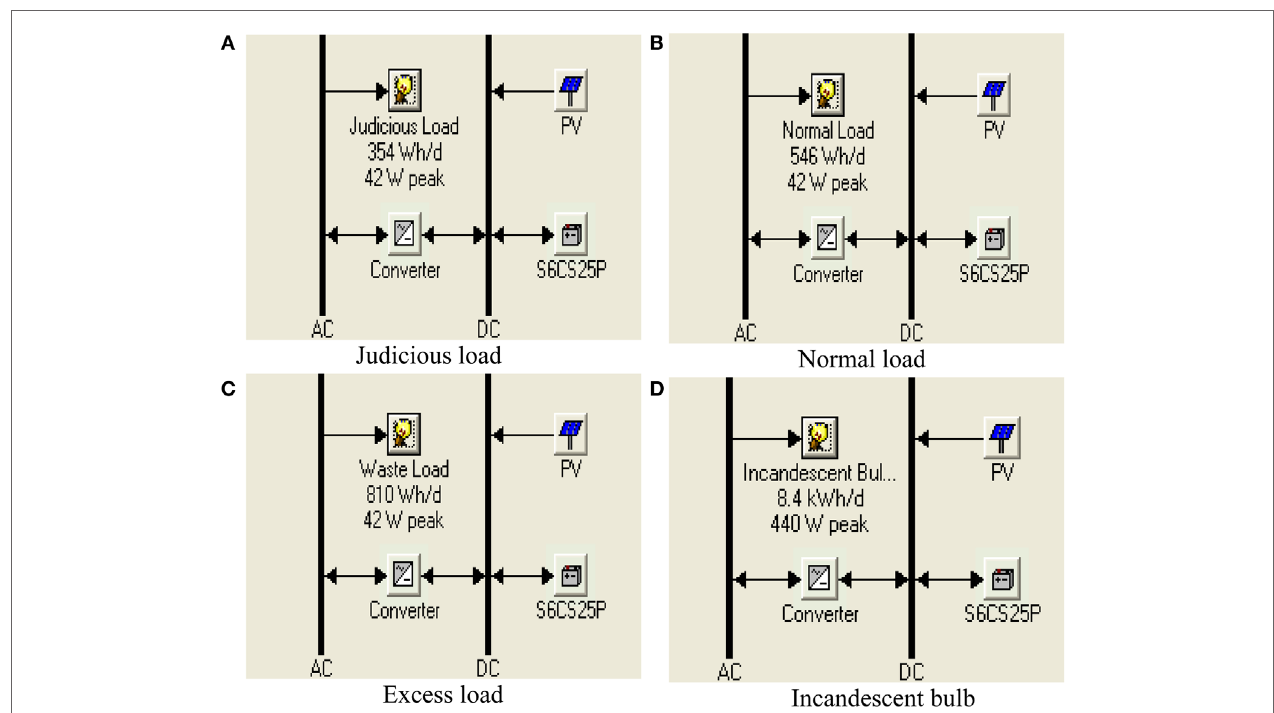
FigUre 7 | The network architecture for the hOMer simulator on (a) judicious load, (B) normal load, (c) excess load, and (D) incandescent bulb